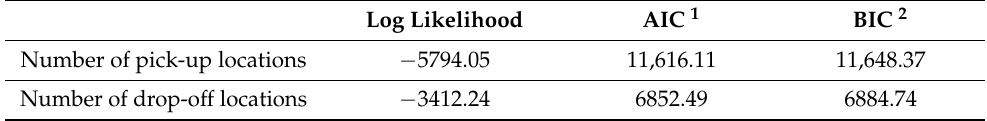
Table 4. Comparison criteria for pick-up and drop-off